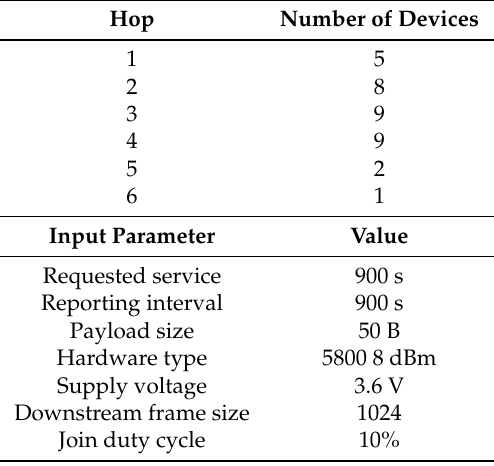
Table 4. Performance Estimator input.